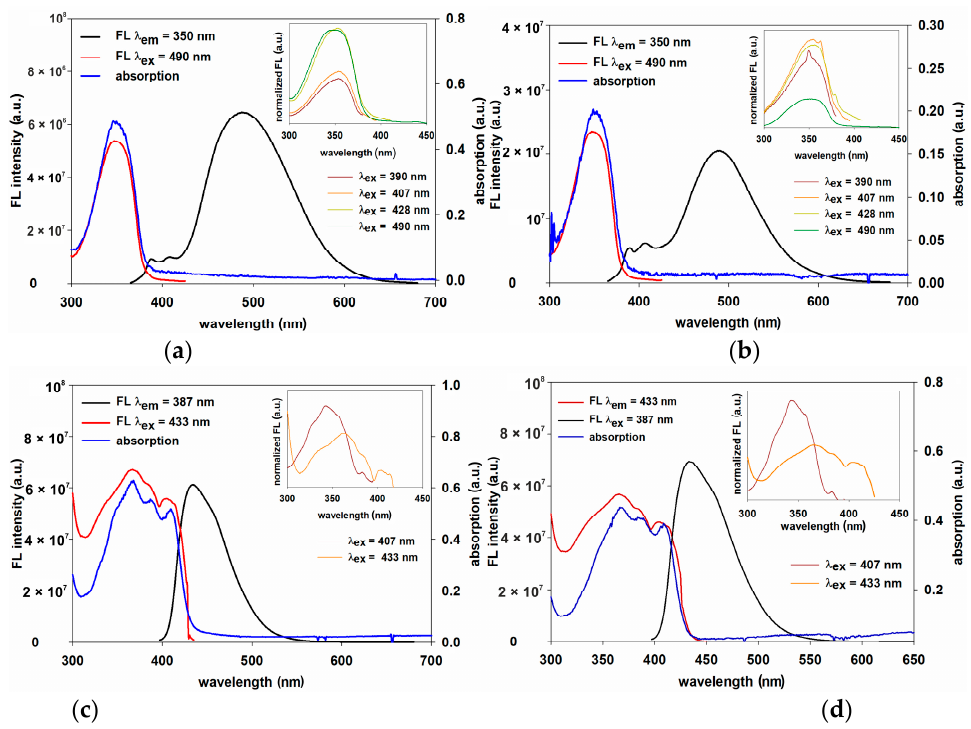
Figure 11. Emission and excitation fluorescence spectra with absorbance spectra of ( a ) LPSQ-triazole-Py, ( b ) POSS-triazole-Py (in THF) and ( c ) LPSQ-amide50-Py, ( d ) POSS-amide-Py (in DMF). All measurements for solutions at c Py = 10 − 6 mol/L.